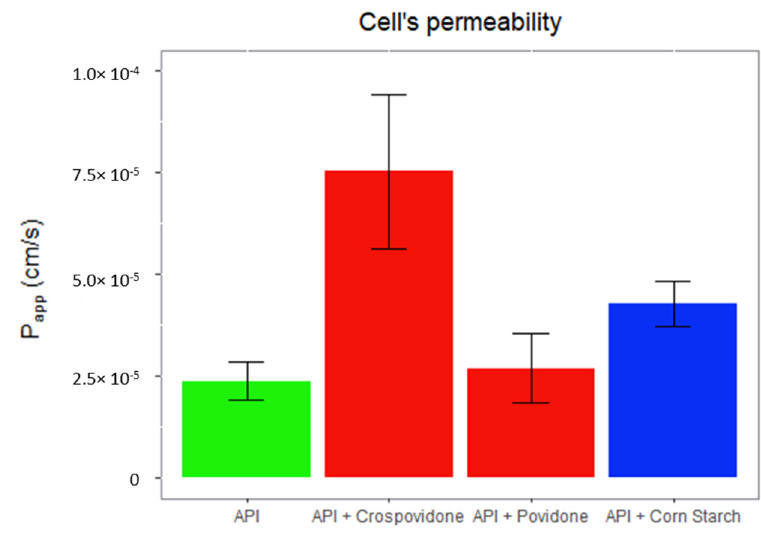
Figure 6. Permeability of silodosin on its own and in presence of excipients.